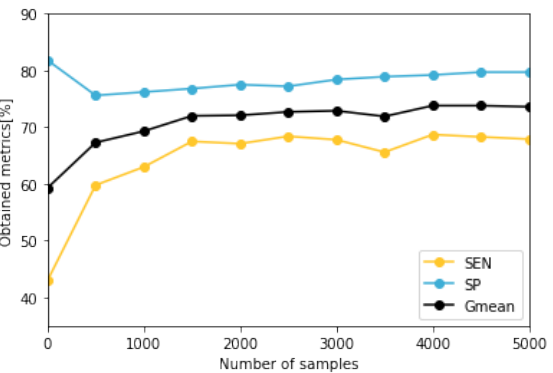
Figure 5. Representation of the obtained metrics related to the amount of days used to augment the real data set.